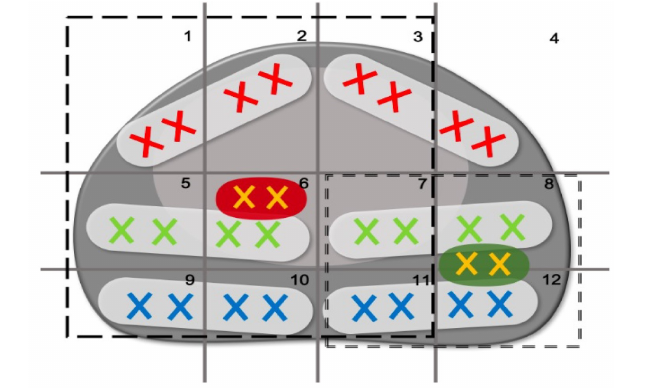
Fig. 2. Schema of sTB. For the red target lesion, the sTB template included TB for 2 cores and SB for 18 cores (sectors 1–3, 5–7, and 9–11 in the dashed frame). For the green target lesion, the sTB template included TB for 2 cores and SB for 8 cores (sectors 7, 8, 11, and 12 in the double dashed frame). SB, systematic biopsy; sTB, saturation target biopsy; TB, target biopsy.